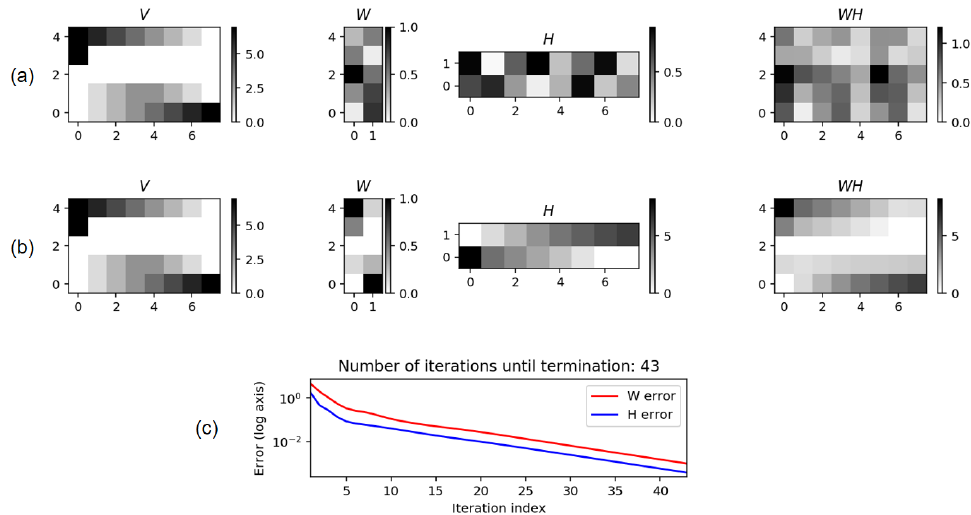
Figure 24. NMF procedure applied to a toy example. ( a ) Matrix V and randomly initialized matrices W and H . ( b ) Matrix V and matrices W and H after training. ( c ) Error terms over